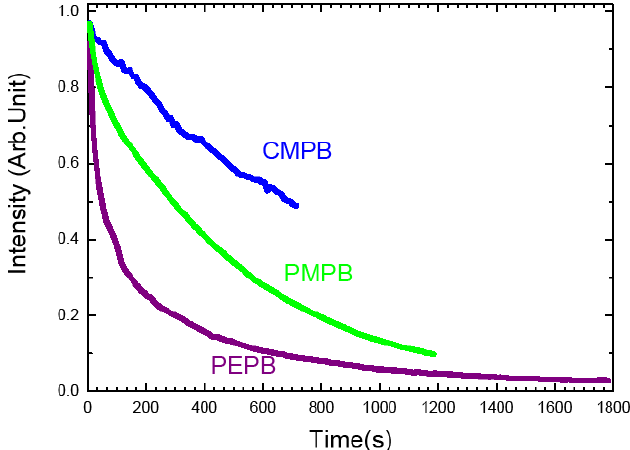
Figure 5. Evolution of PL intensity as a function of illumination time for PEPB PMPB and CMPB thin films. The samples are excited with the 325 nm line of a HeCd laser at 7 mW (corresponding to a fluence 0.175 W·cm −2 ) in air. The PL intensities are normalized to 1 at t = 0 s.